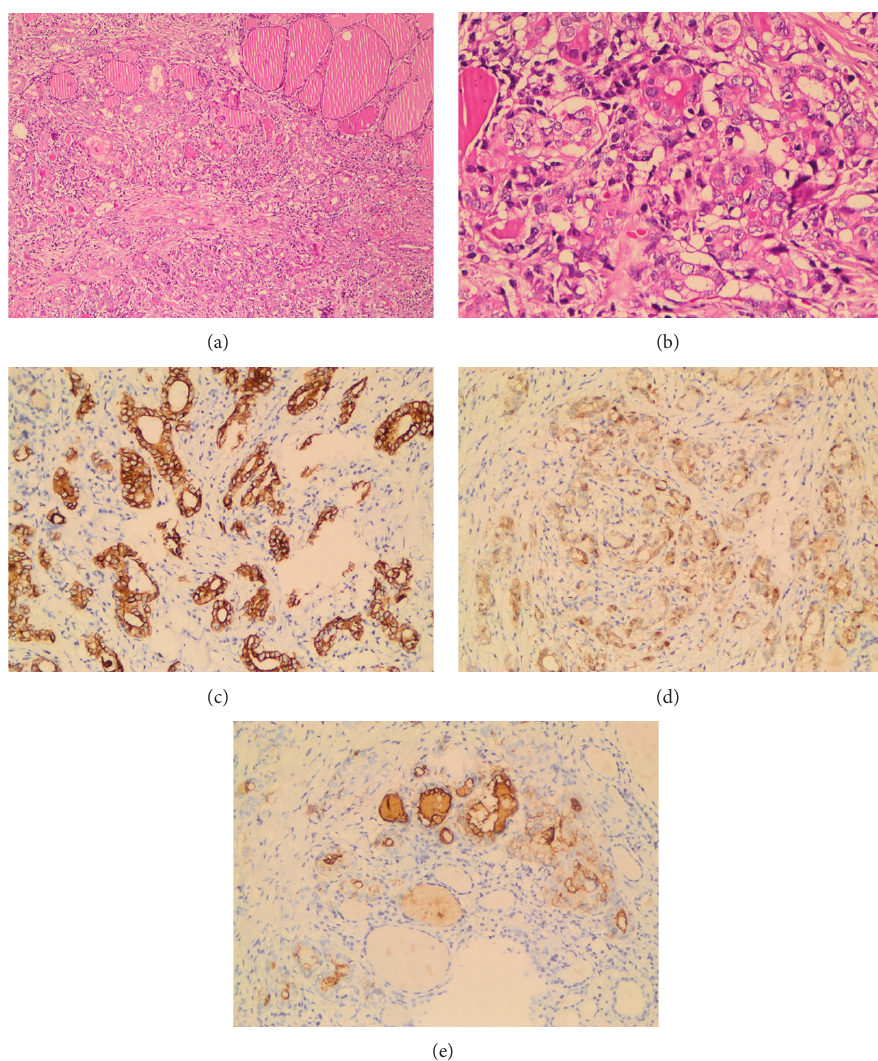
Figure 4: (a) Tumor has papillary architecture which is < 1cm with desmoplastic stroma and normal thyroid follicles identified, the upper right side ( × 200, H&E). (b) Nuclei are large and oval in shape and show clearing ( × 400, H&E). (c) The tumor cell cytoplasm is strongly reactive with CK19 ( × 200, CK19). (d) Galectin-3 staining is confined to the cytoplasm of the tumor cells ( × 200, Galectin-3). (e) HBME-1 staining is present within the plasma membrane of the tumor cells ( × 200,